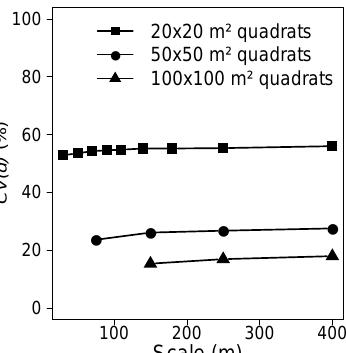
Figure 4. Spatial variograms of AGBD for three different spatial resolutions. Ensemble average variograms for AGBD in square sub- plots of size 20 × 20m, 50 × 50m and 100 × 100m, with variances transformed into distance-specific coefficients of variation (CV (d) ). Variograms for individual plots at each spatial resolution are shown in Fig. S5. Separate graphs for each site, with confidence inter- vals for the null hypothesis of no spatial correlation, are shown in Figs.